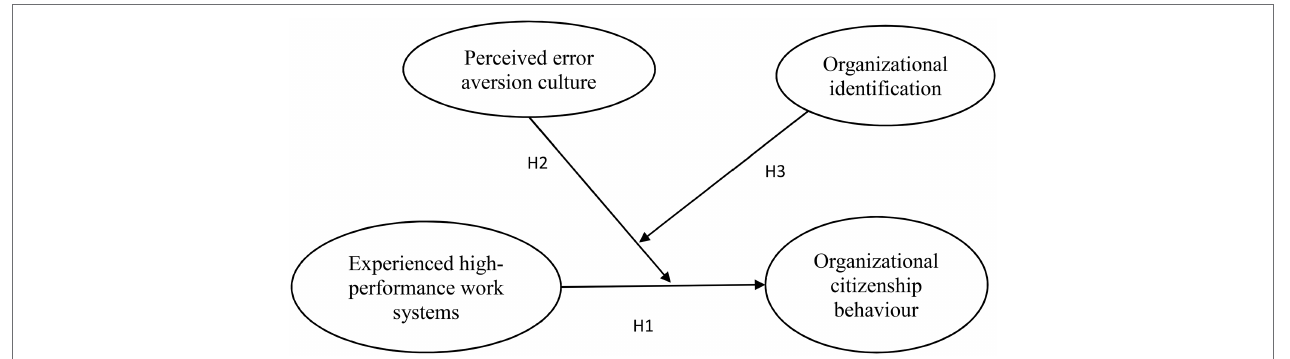
FIGURE 1 | Conceptual